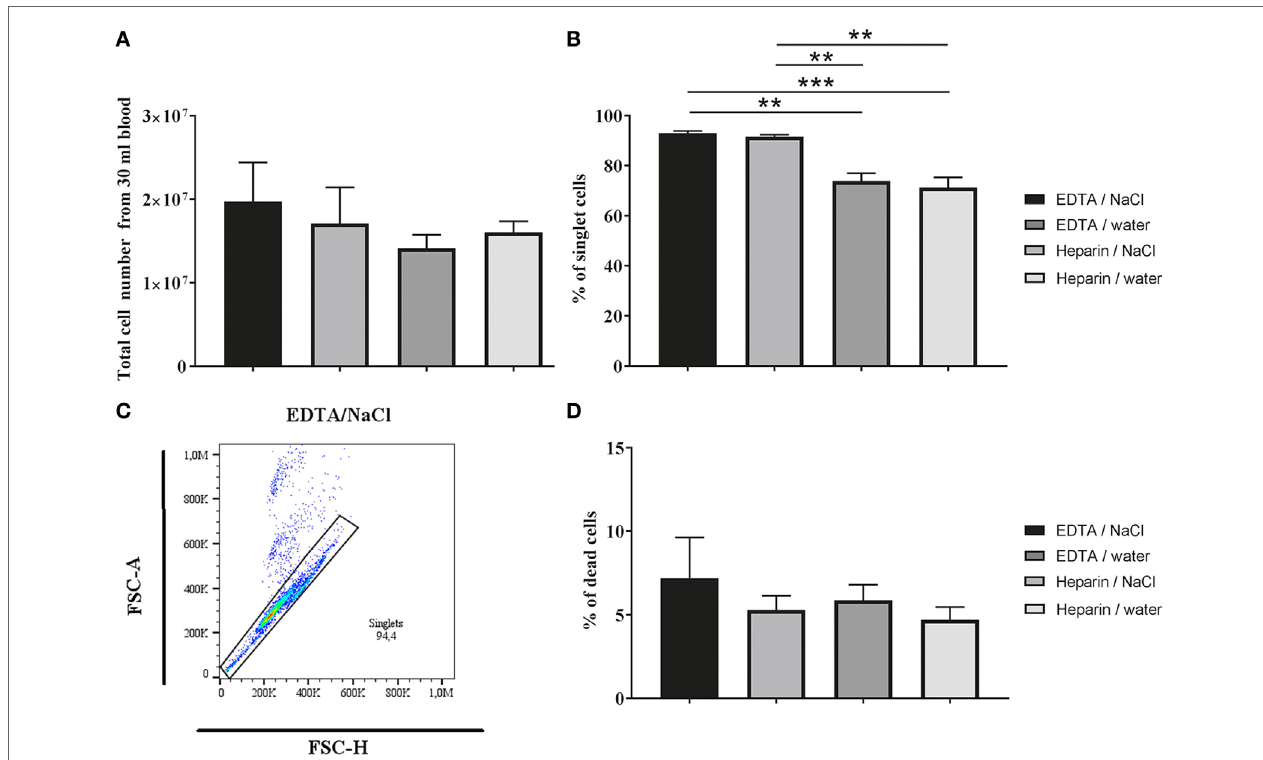
FIGUrE 1 | Cell harvest and dead cells after Biocoll density gradient centrifugation. (A) Total number of granulocytes after isolation from 30 ml blood ( n = 5; one-way ANOVA P = 0. 2,606) determined by counting in a Neubauer chamber. A slight but not significant difference in the cell number was detected between the tested groups. (B,c) The percentage of singlet cells was analyzed by flow cytometry ( n = 5, one-way ANOVA P = 0.0002). Significant difference was detected between K 3 EDTA and lithium heparin. The gating strategy is shown in (c) . (D) Percentage of dead cells from granulocytes (singlets) using propidium iodide staining analyzed by flow cytometry ( n = 5; one-way ANOVA P = 0.4543). No significant difference in viability was detected. One-way ANOVA followed by Tukey’s multiple comparisons test revealed no significant difference between anticoagulants and/or erythrocyte lysis buffer in total cell number and dead cells. P values * P < 0.05, ** P < 0.01, and *** P < 0.001 were considered